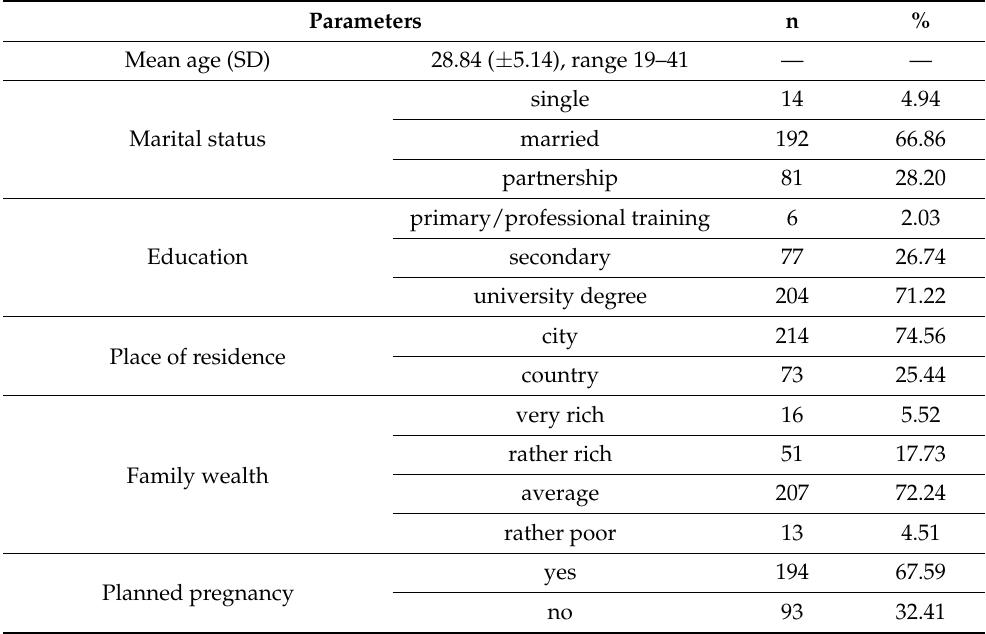
Table 1. Characteristics of the study group—pregnant women with